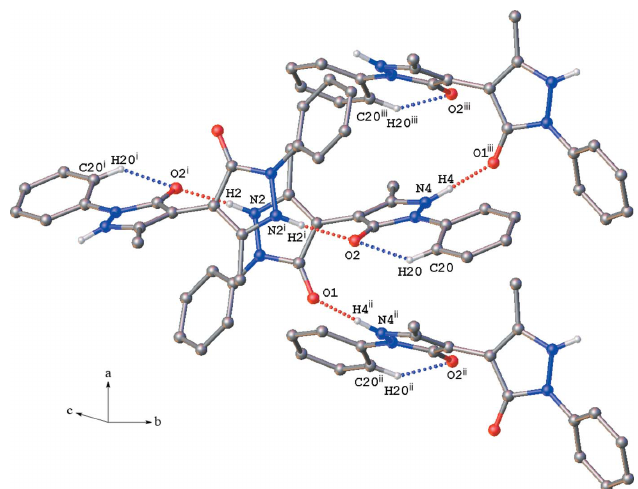
Figure 2 View of the intramolecular (blue dotted lines) and intermolecular (red